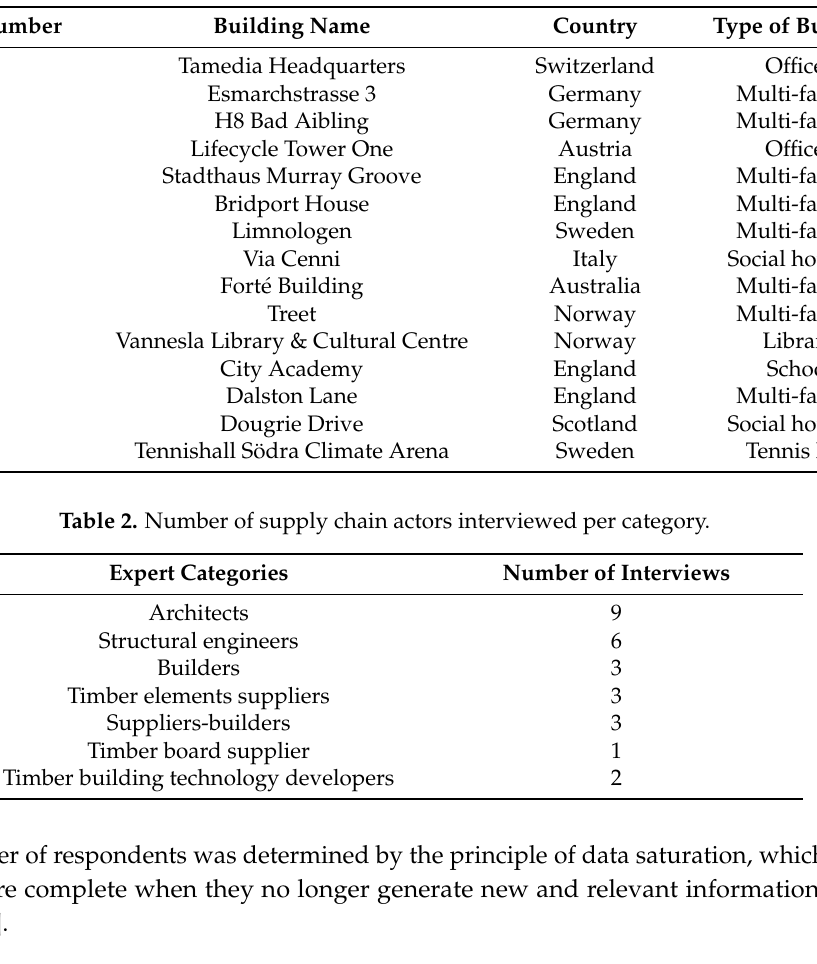
Table 1. Selection of timber structure projects used to initiate contacts with supply chain members.